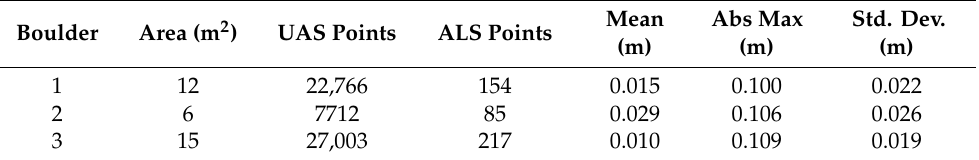
Table 8. UAS vs. LLS for